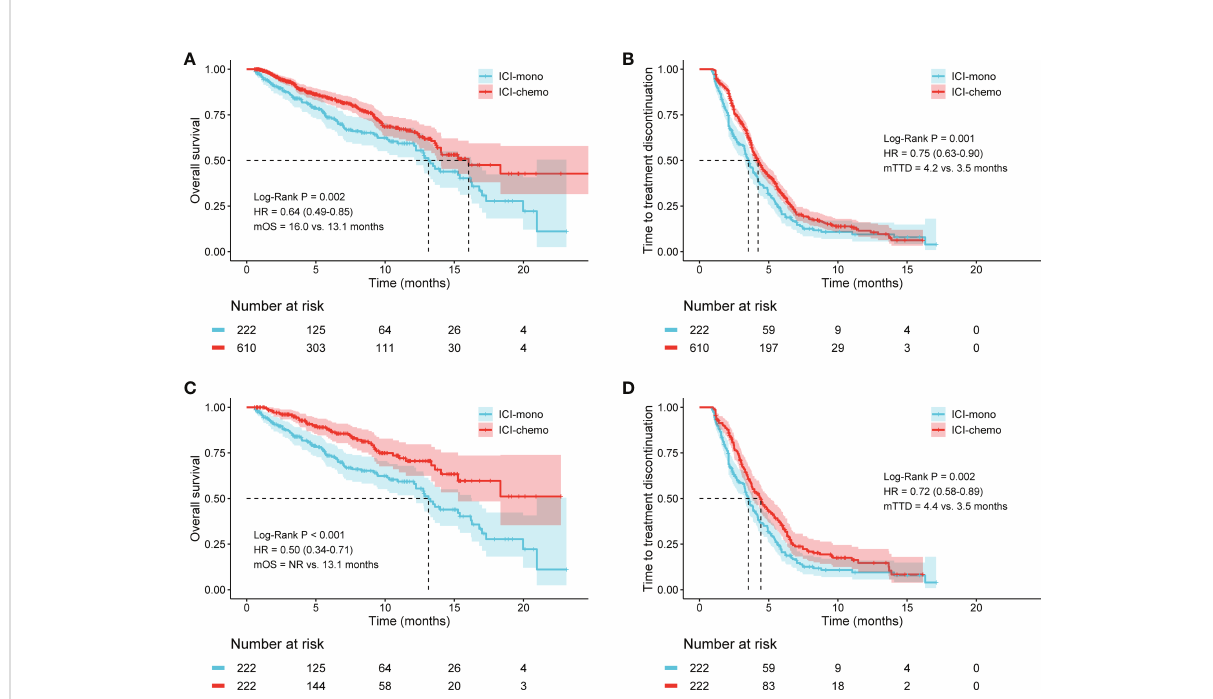
FIGURE 2 Kaplan-Meier curves for overall survival (OS) and time to treatment discontinuation (TTD) in the initial cohort and the matched cohort. (A) ICI- chemo versus ICI-mono for OS in the initial cohort; (B) ICI-chemo versus ICI-mono for TTD in the initial cohort; (C) ICI-chemo versus ICI- mono for OS in the matched cohort; (D) ICI-chemo versus ICI-mono for TTD in the matched cohort. HR, hazard ratio; NR, not